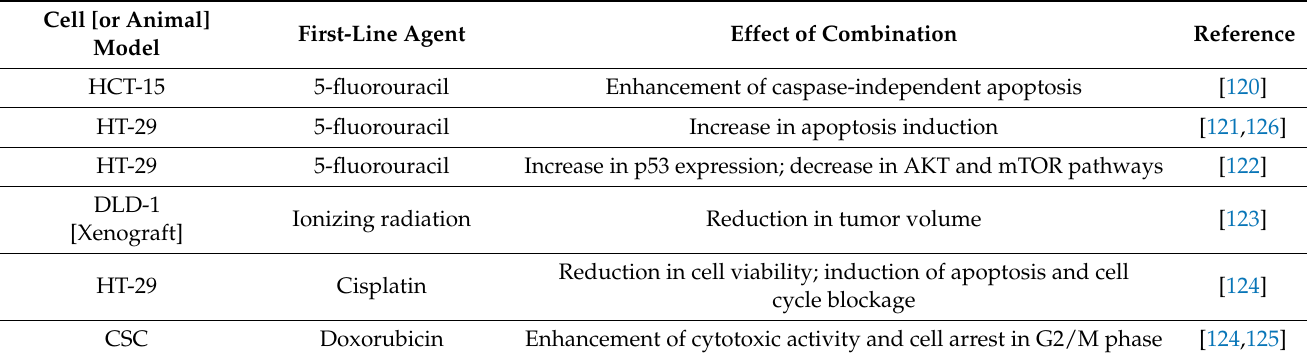
Table 5. Effects of co-administration of quercetin with first-line chemotherapeutic agents in CRC experimental